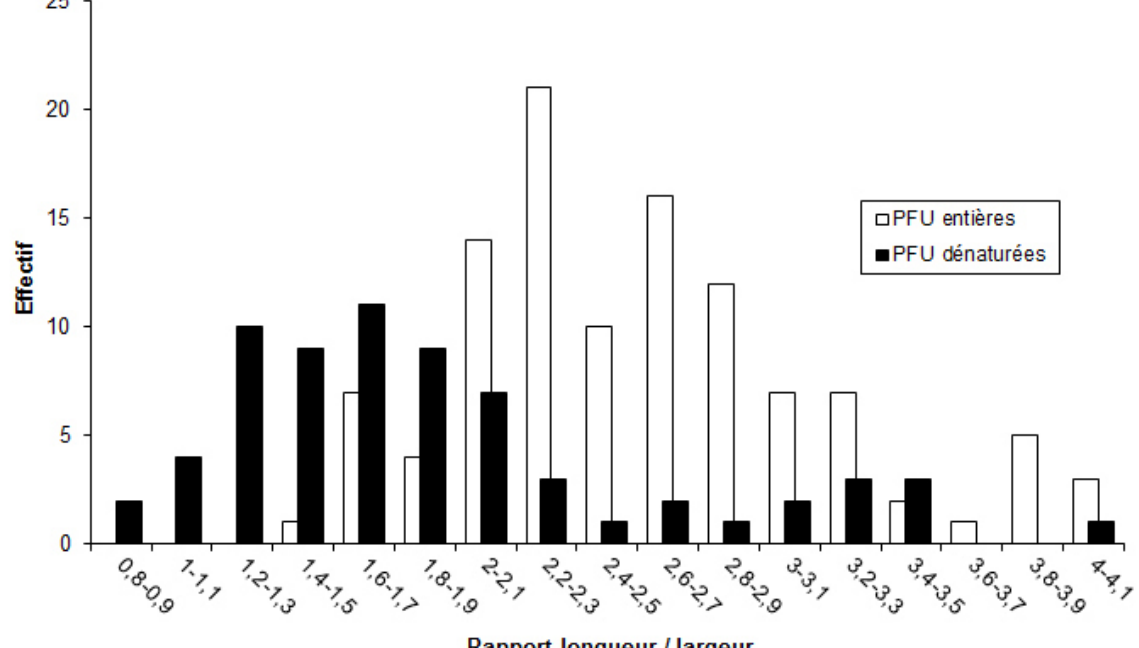
Figure 11. Histogramme du rapport longueur/largeur des pièces façonnées unifacialement de GO-JA-01. Figure 11. Histogram of unifacially shaped artefacts from GO-JA-01 rockshelter length/width ratio.